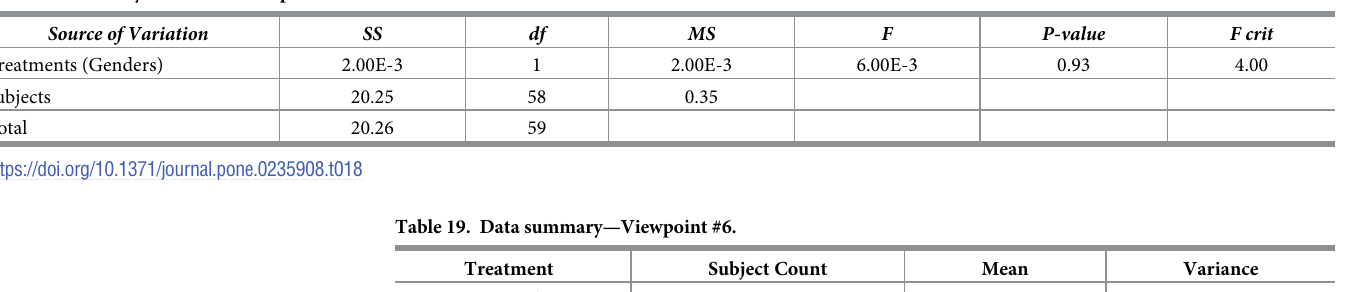
Table 18. One-way ANOVA—Viewpoint #5.